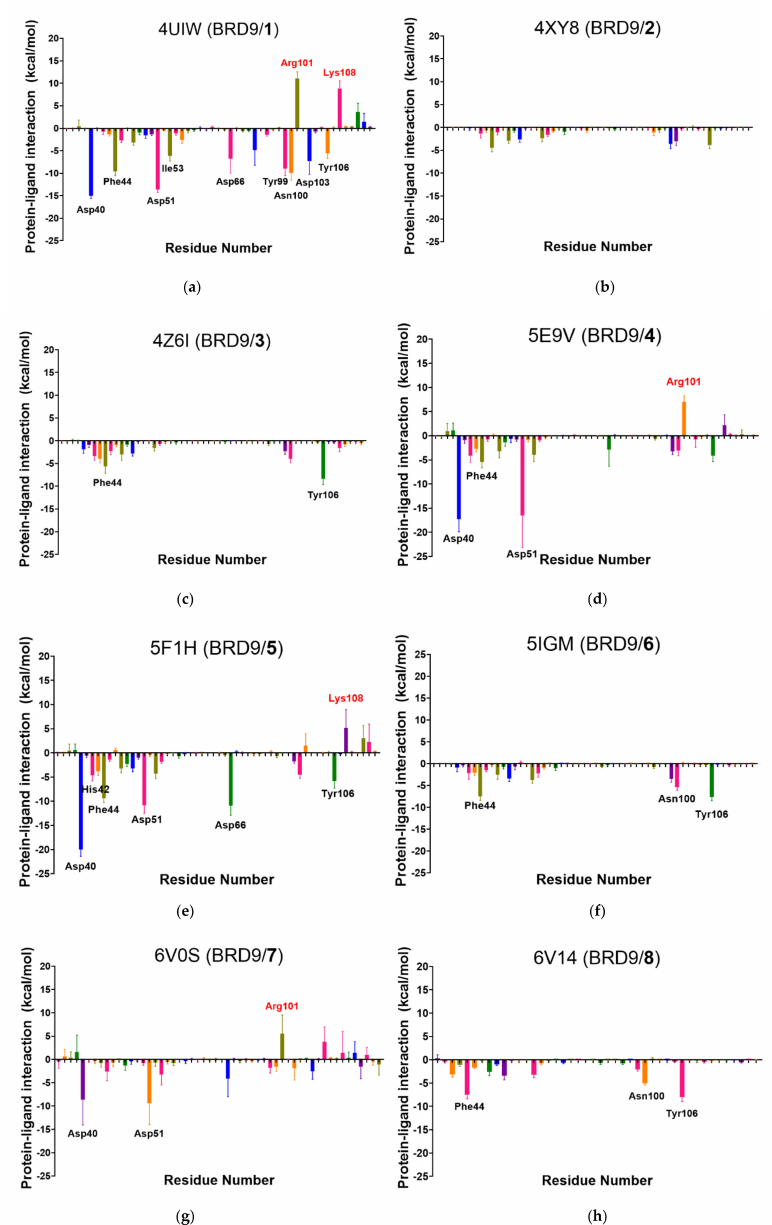
Figure 9. ( a – h ) Per-residue interactions of the 8 complexes reported as the mean value of the three replicated dynamics. Residues with energetic values below − 5.0 kcal/mol are labeled in black and residues above +5.0 kcal/mol are labeled in red, specifically for ( a ) 4UIW, ( b ) 4XYZ, ( c ) 4Z6I, ( d ) 5E9V, ( e ) 5F1H, ( f ) 5IGM, ( g ) 6V0S, ( h )